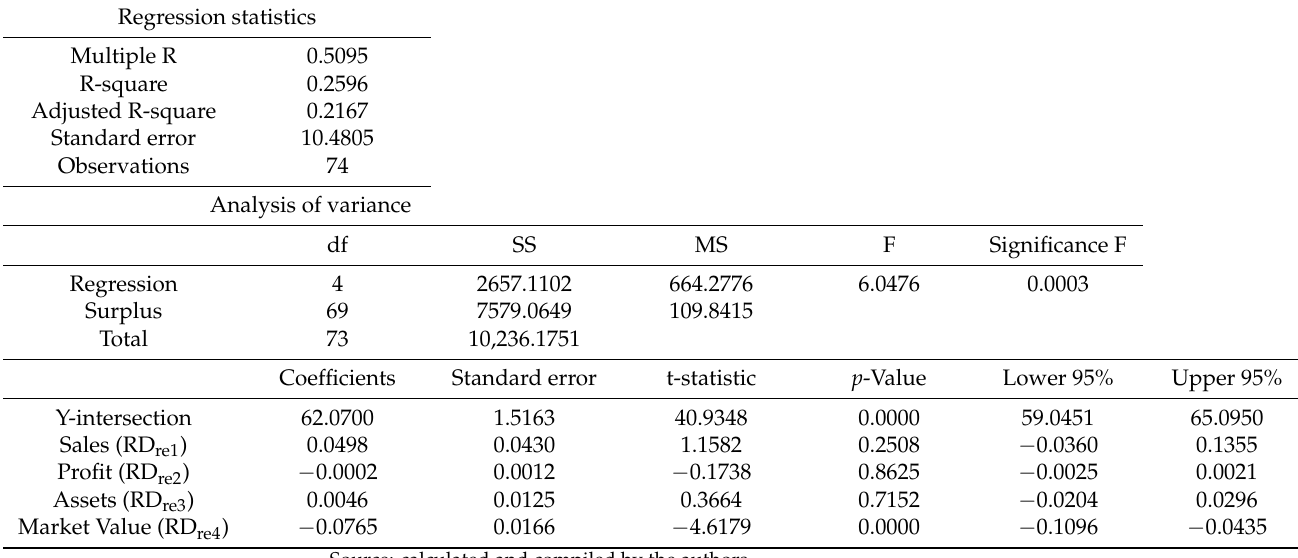
Table 2. Regression analysis of the dependence of the level of corporate social responsibility on the magnitude of financial risks in